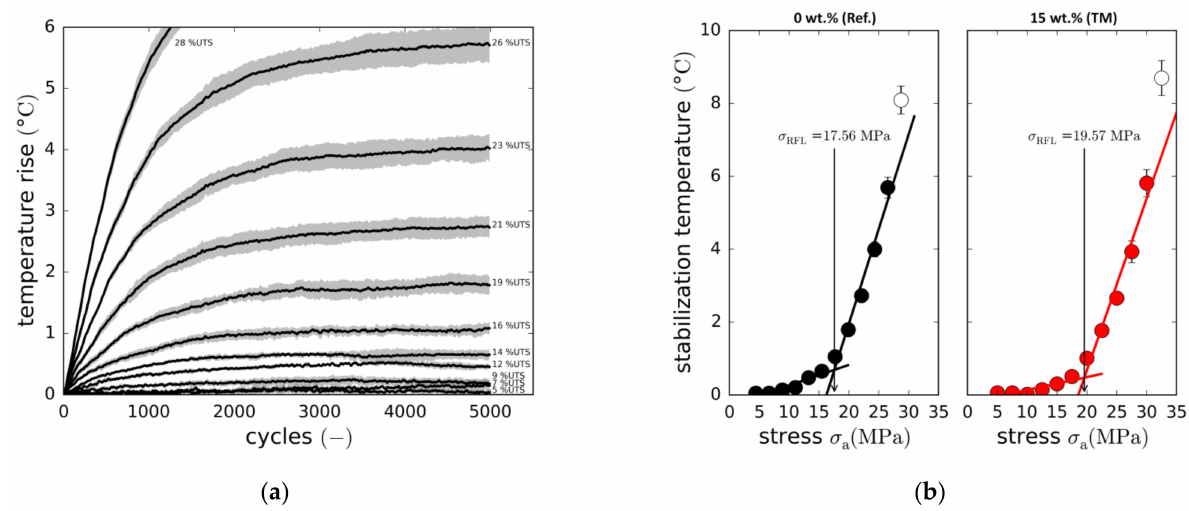
Figure 15. ( a ) Temperature rise of the reference laminate with different relative loads (% UTS), averages of three specimens with standard deviations; ( b ) Stationary temperatures against cyclic load, Risitano fatigue limit (RFL) determination for the reference laminate and the 15 wt.% (TM) boehmite nanoparticle